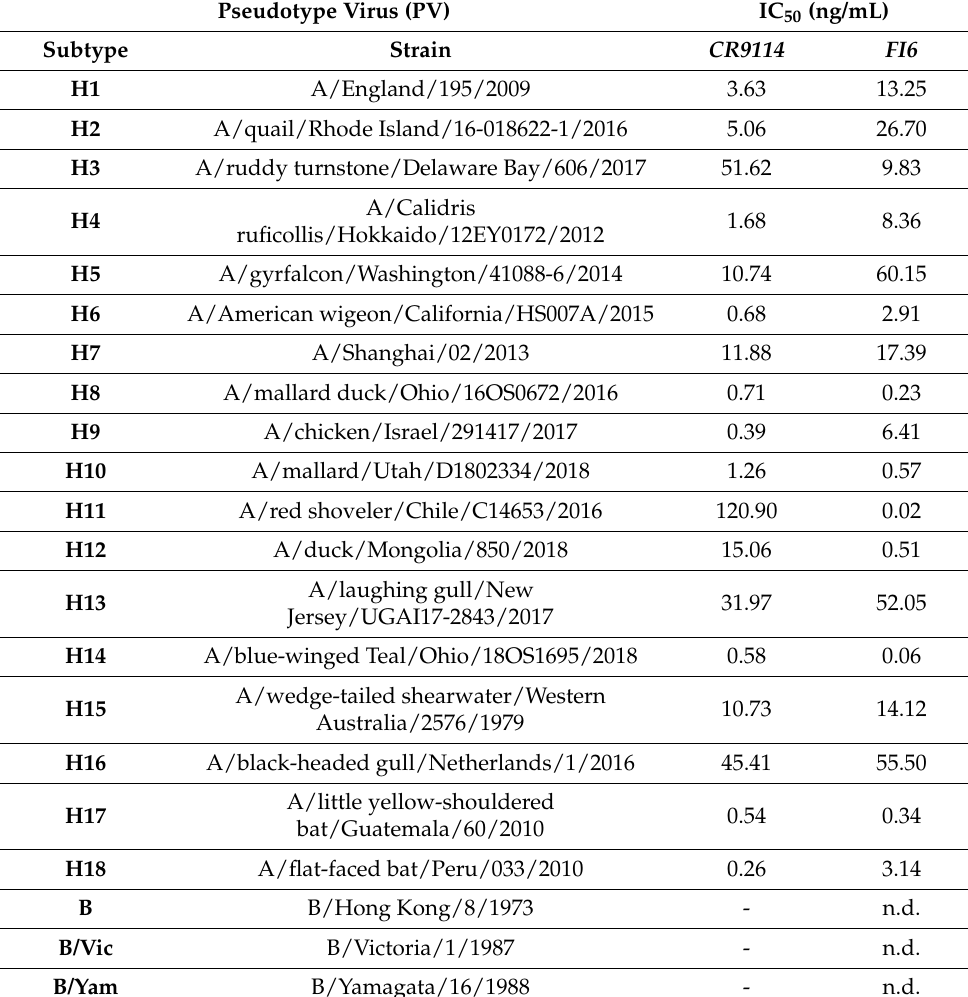
(Table 4). The IC 50 values for FI6 were more varied, with a range of 0.02–60 ng/mL (Table 4). Table 4. IC 50 (half-maximal inhibitory concentration) values of CR9114 and FI6 against representative influenza PV in vitro. (-) indicates no neutralization. n.d. indicates the experiment was not done. Pseudotype Virus (PV) IC 50